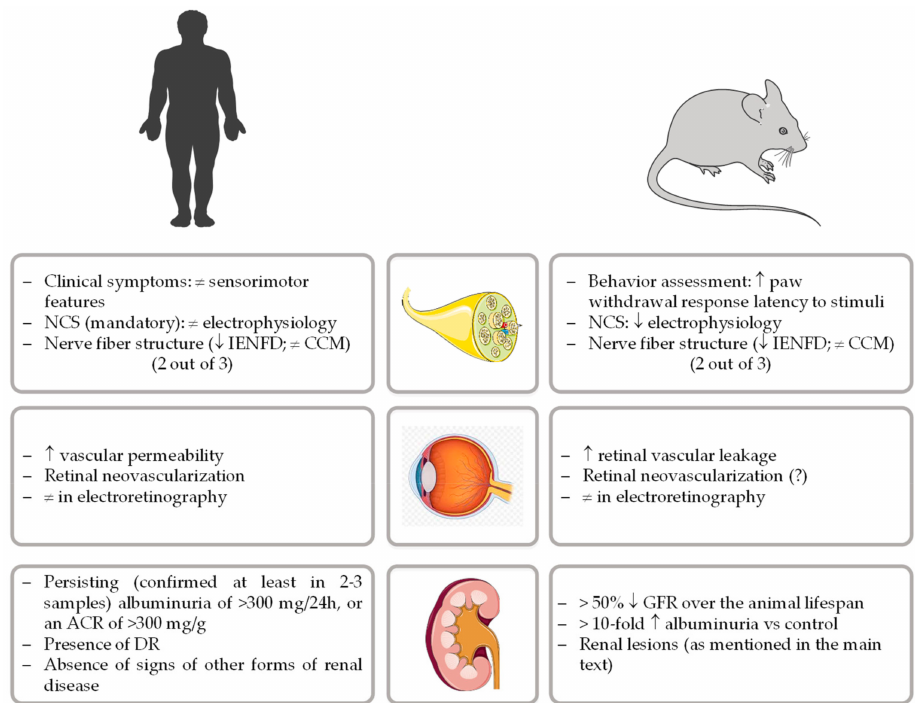
Figure 1. Comparative criteria for human and rodent models of diabetic peripheral neuropathy, retinopathy, and nephropathy. (NCS, nerve conduction studies; IENFD, intraepidermal nerve fibers density; CCM, corneal confocal microscopy; ACR, albumin-to-creatinine ratio; DR, diabetic retinopathy; GFR, glomerular filtration